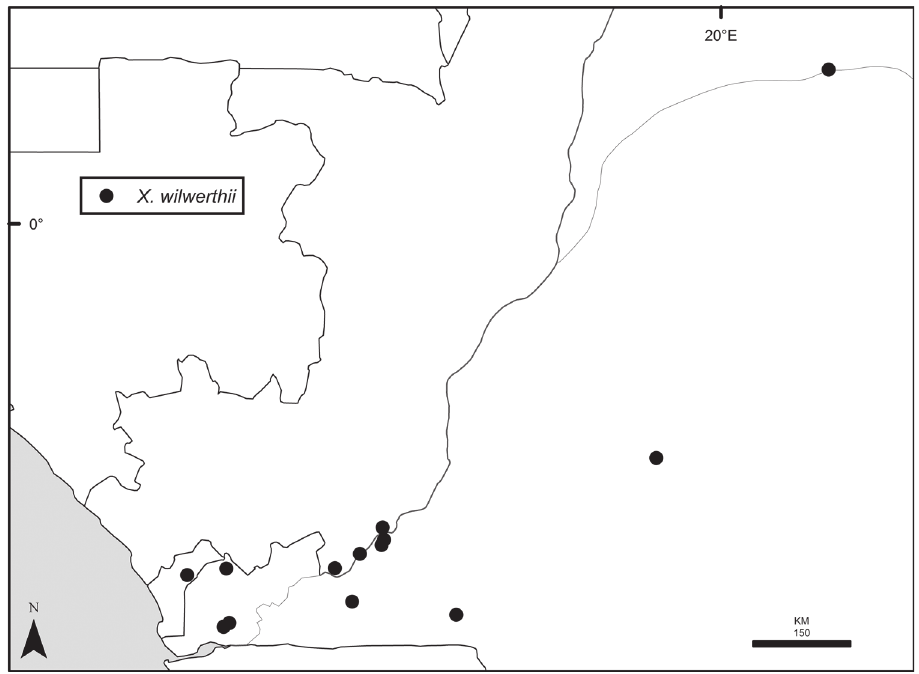
Figure 32. Distribution of Xylopia wilwerthii . Bolder lines represent country borders, fainter lines lakes and major